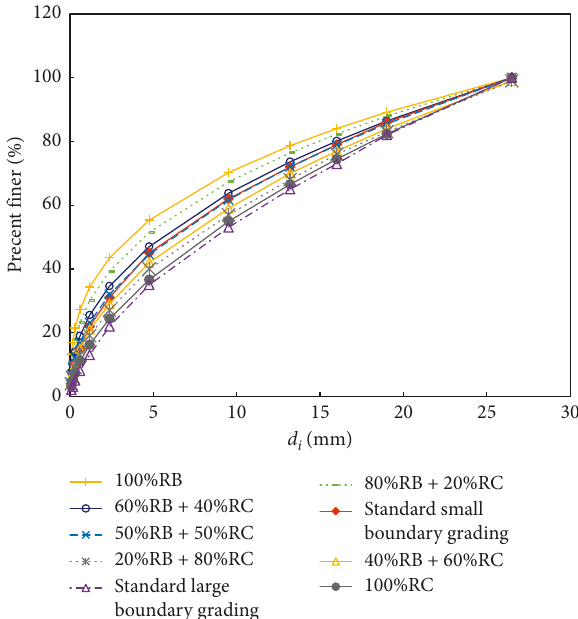
Figure 7: Gradation curve (particle diameter from 19mm to Table 4: Gradation of recycled mixed aggregates.